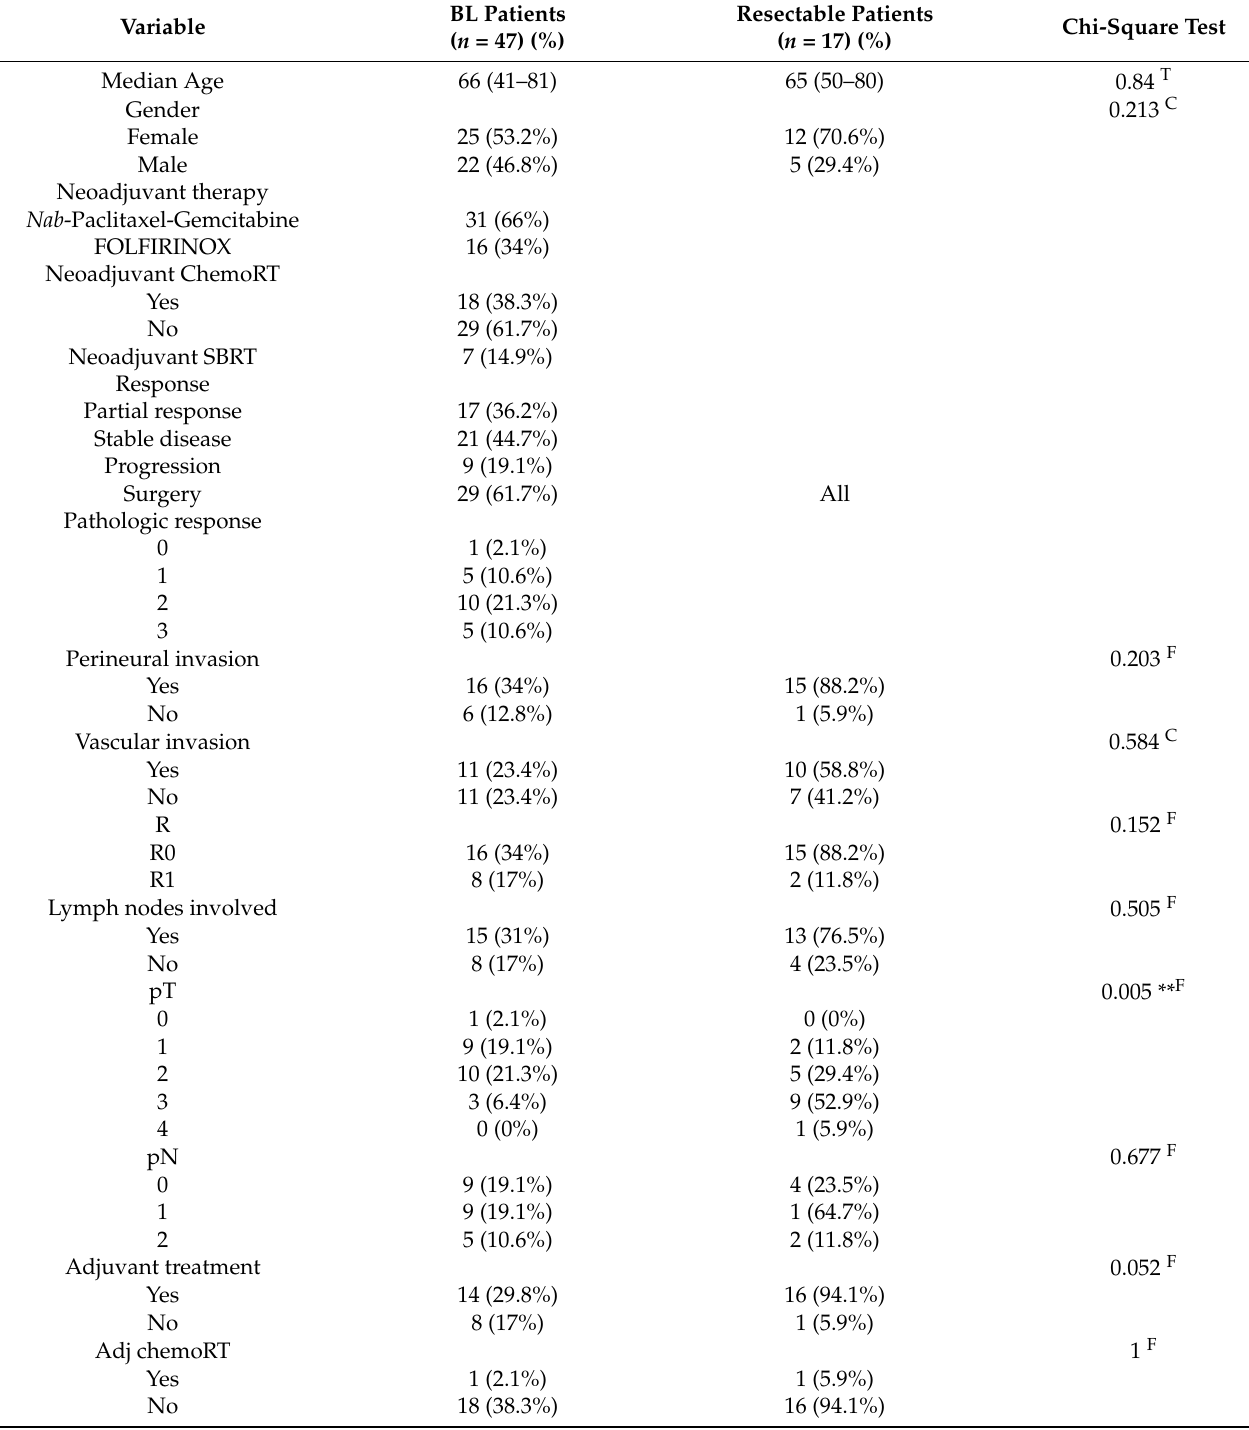
Table 1. Clinical and demographic characteristics of BL and resectable